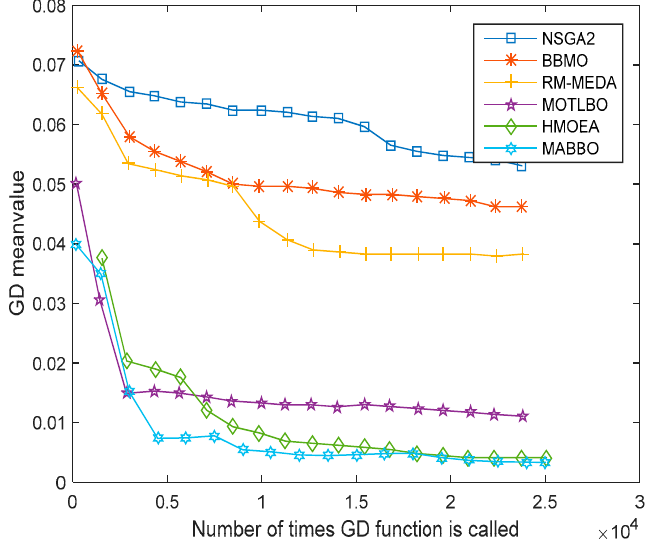
Figure 3. The GD index of six algorithms on DTLZ2 test problem.